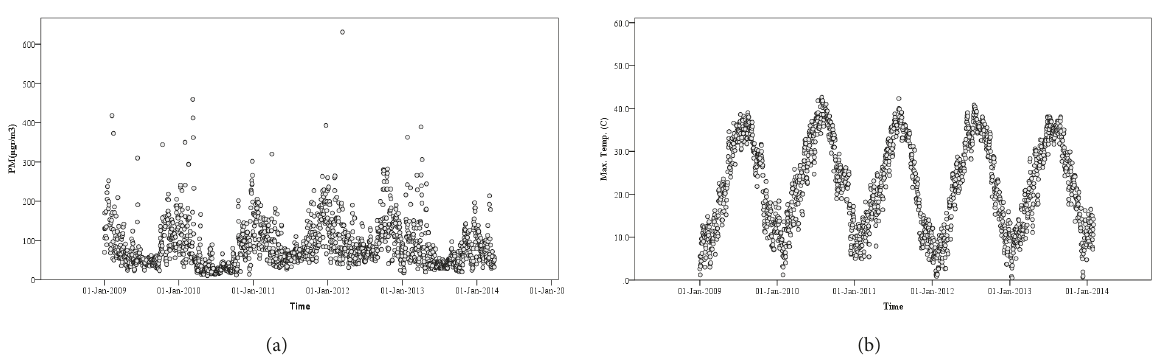
Figure 1: Daily mean of (a) particulate matter ≤ 10 𝜇 m (PM10) levels and (b) mean temperature ( ∘ C) in Gaziantep City Center, 01. 09.2009 to 31. 01.